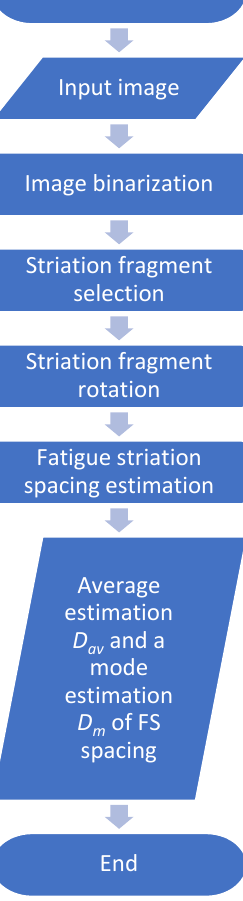
Figure 2. The flowchart of proposed method for automated FS spacing evaluation. The changes in the grey levels of the fractographic image along its columns were examined pixel by pixel. Local minima were selected on the obtained image intensity curve along the column and marked with red labels (Figure 3a). By definition, the point is called the local minimum if the points on each side have a greater value of the function. It means that the pixel with the lowest grey level value in comparison with the previous ones and the next one in the column is chosen as the local minimum. Three neighbor pixels in the column were compared. When comparing more neighboring pixels than fatigue striation spacing (which is unknown before processing), there is a risk of missing some of the striations. Since the intensity function of the fractographic images is not smooth, the local minima can be both in the area of the depressions and the protrusions. To eliminate local minima in the area of protrusions, the step of finding local minima was repeated only for the local minima points obtained in the previous step (Figure 3b).